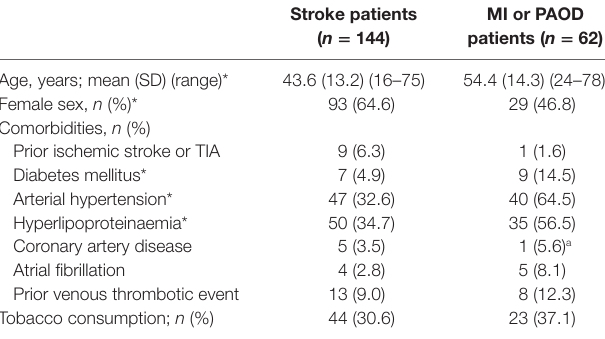
TaBle 1 | Baseline data of stroke patients compared to patients with myocardial infarction (MI) or peripheral arterial occlusive disease (PAOD). stroke patients ( n =